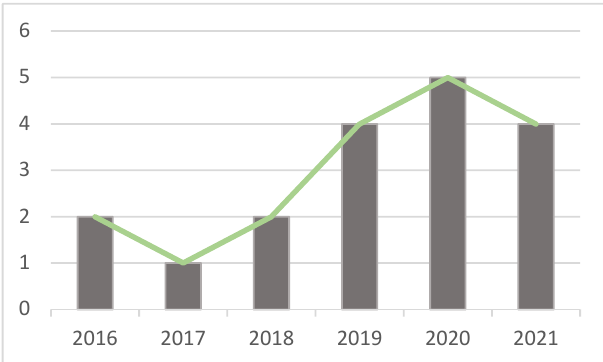
Figure 1. Number of publications identified in timeline (compiled by author).